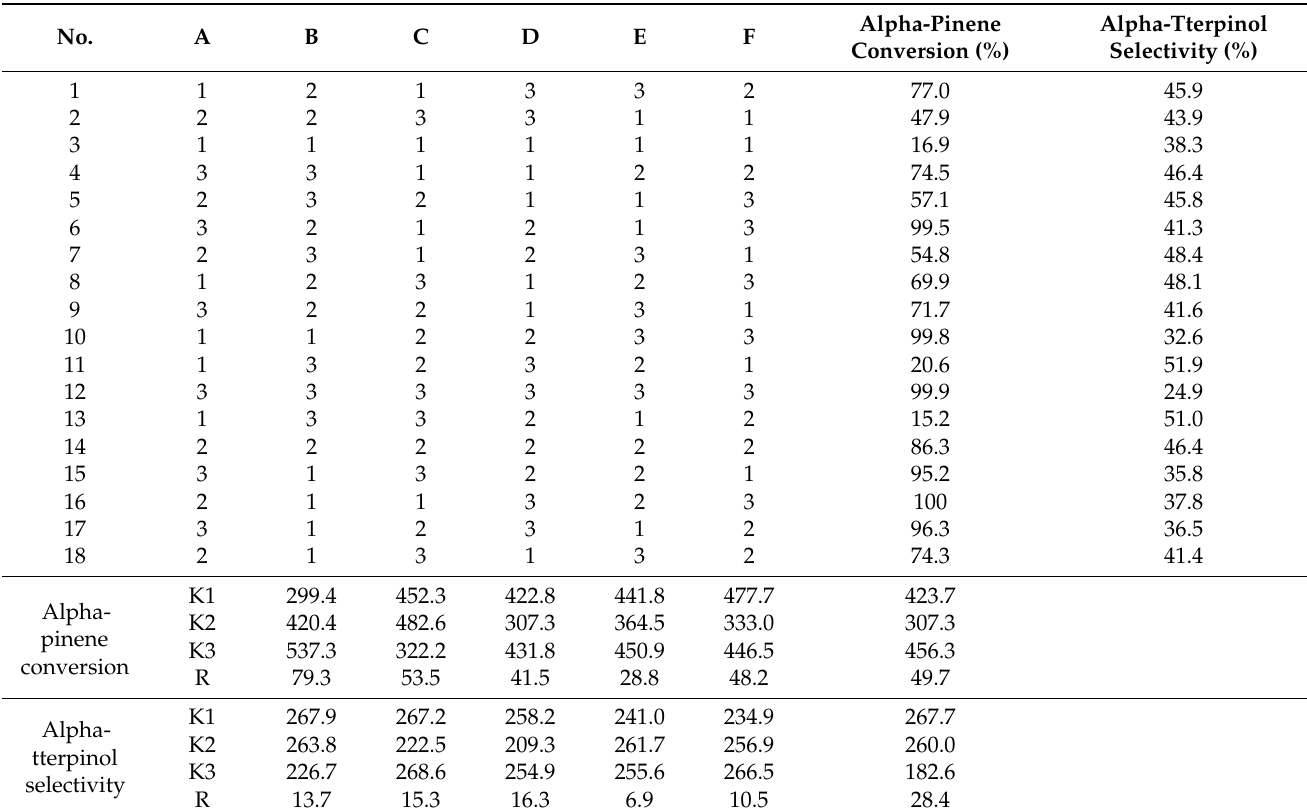
Table 5. Results and analysis of the orthogonal experiment.